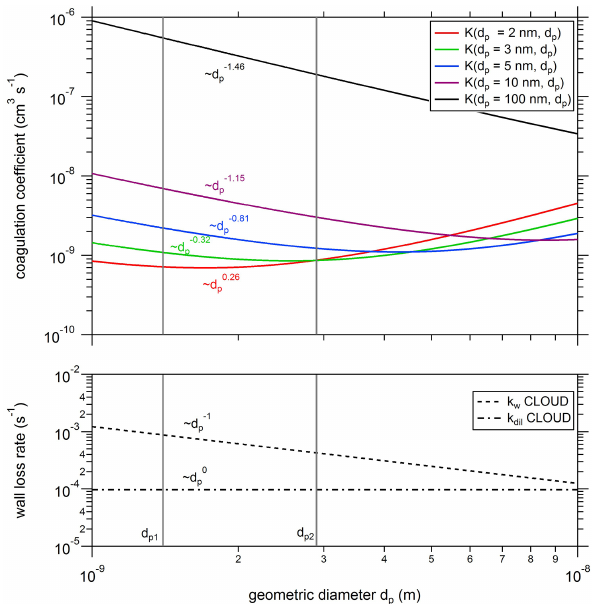
Figure 1. Coagulation coefficient, K , as a function of particle size, d p (upper panel). Coagulation coefficients are calculated between two particles, where one particle has a constant size (indicated in the legend of the figure) and the second particle diameter varies be- tween 1 and 10nm. The wall loss rate for the CLOUD chamber as a function of particle size is shown by the dashed curve (lower panel), whereas the dilution rate is indicated by the dash-dotted line. Slopes of the curves are indicated for the range between d p 1 (1.4nm, i.e., 1.7nm in mobility diameter) and d p 2 (2.9nm, i.e., 3.2nm in mobil- ity